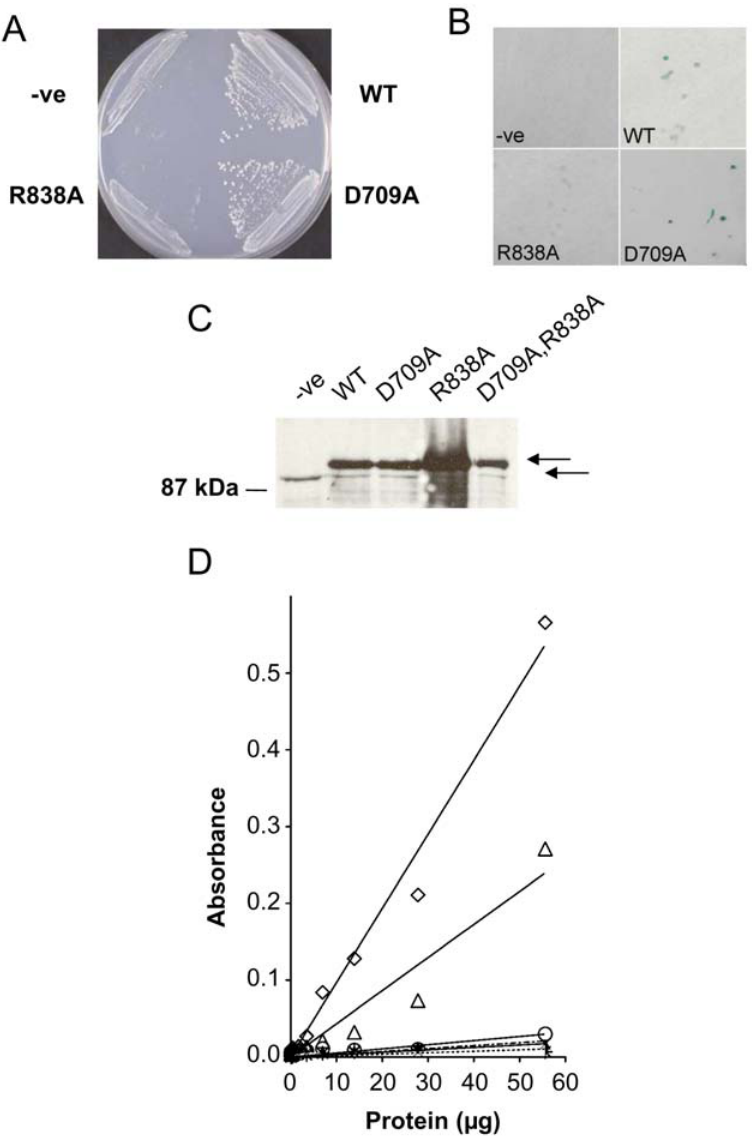
Figure 6. Pik1 R838, but not D709, is required for binding to Cdc4. (A) Yeast two-hybrid colony formation assay. S. cerevisiae cells were transformed with a two-hybrid bait vector carrying the S. pombe cdc4 cDNA sequence fused to the GAL4 DNA binding domain (Cdc4- GAL4 DB). This strain was co-transformed with the two-hybrid prey vector alone (-ve), or with the prey vector carrying the S.pombe pik1 C-terminal wild-type sequence fused to the GAL4 transcription activation domain (Pik1 507–851 - GAL4 TA; WT), or with the latter carrying either the D709A or R838A substitution. Colony formation is indicative of a protein-protein interaction. Results shown are representative of 3 separate experiments with the same strains. (B) X-gal colony filter assays. Nitrocellulose filters were overlayed onto the S. cerevisiae colonies grown on SD –Leu 2 Trp plates, submerged in liquid nitrogen and incubated in X-gal solution to monitor b -galacatosidase activity. Cells carrying the pik1 wild-type and D709A alleles fused to the GAL4 -TA domain in the pBI771 vector and cdc4 sequence fused to the GAL4 -BD in the pBI880 vector turned blue and were thus positive for the Pik1p-Cdc4p interaction. (C) Immunoblot assay. Accumulation of Pik1 upon ectopic expression of pik1 alleles from an episome under the control of the nmt1 promoter in cells carrying the intact chromosomal pik1 locus was assessed by immunoblot analysis. S.pombe cells transformed with a pREP1 plasmid carrying either the full length pik1 wild-type or mutated cDNA sequences were cultured in the absence of thiamine. Cell lysates (5 m g protein) were subjected to SDS-PAGE and Pik1 was visualized with a primary anti-Pik1 rabbit antiserum and a secondary goat anti-rabbit IgG- HRP (horseradish peroxidase)-conjugated antibody. Bar=87 kDa molecular weight marker. Results shown are representative of 3 separate experiments with the same strains. The upper arrow represents the accumulation of the 97 kDa Pik1 wild-type and mutant proteins. The lower arrow represents an unknown polypeptide of 93 kDa, which is present in all samples including lysates of cells carrying the vector alone and lysates of cells cultured in repressed and derepressed conditions. (D) Sandwich ELISA to assess interaction between full length Pik1 and Cdc4. ELISA plates were coated with purified Cdc4, and then washed and blocked. Wells were subsequently incubated with 2-fold serial dilutions of lysates prepared from S.pombe cells grown in the absence of thiamine (solid line) and expressing the full-length pik1 cDNA sequence (open triangle), or pik1 cDNA sequences carrying mutations R838A (circle), D709A (diamond), or both R838A and D709A (cross hatch). Negative controls included lysates prepared from cells transformed with the pREP1 plasmid alone (dotted line, open square) or cultured under repressed conditions (with thiamine, dotted line, closed triangle). Results shown are representative of 3 separate experiments with the same strains.